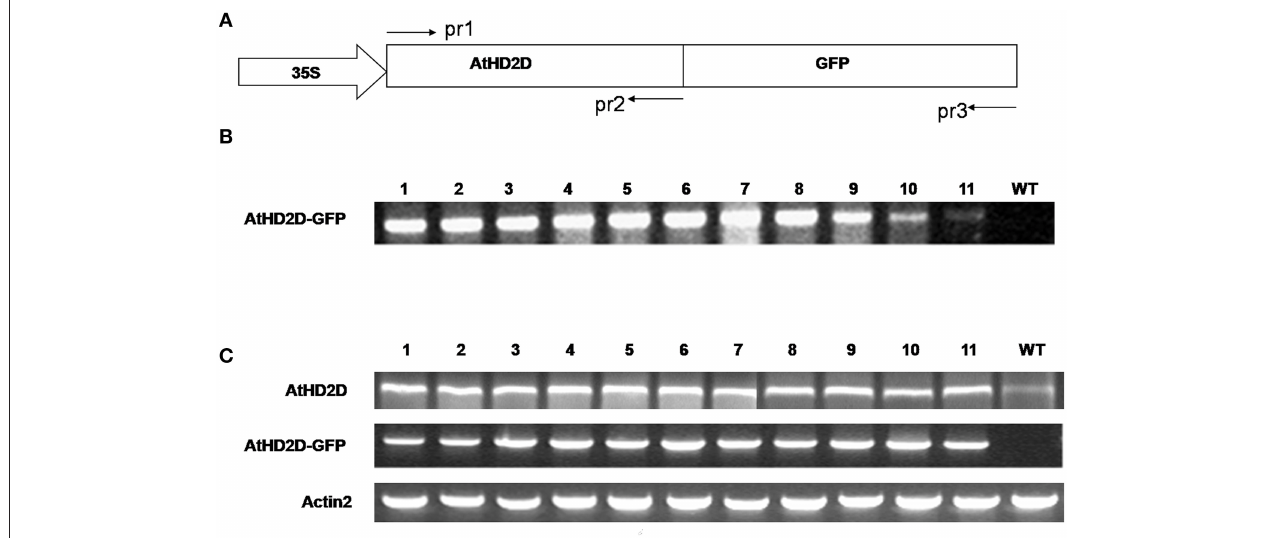
FIGURE 2 | Expression analysis of AtHD2D and of AtHD2D-gfp in transgenic Arabidopsis thaliana plants. (A) Diagram of the 35S:AtHD2C-gfp construct. AtHD2D CDS was fused with the gfp -coding region driven by a 35S promoter. The primers, pr1, pr2, and pr3, used to analyze AtHD2D and AtHD2D-gfp in transgenic plants were shown. (B) PCR analysis of 35S:AtHD2D-gfp transgenic and wild-type (WT) plants using primer pairs of pr1 and pr3. No PCR product was found in WT. (C) RT-PCR analysis of AtHD2D and AtHD2D-gfp expression in transgenic and wild-type plants using the primer pairs of pr1 and pr2 or pr1 and pr3. No RT-PCR product of AtHD2D-gfp was found in WT.